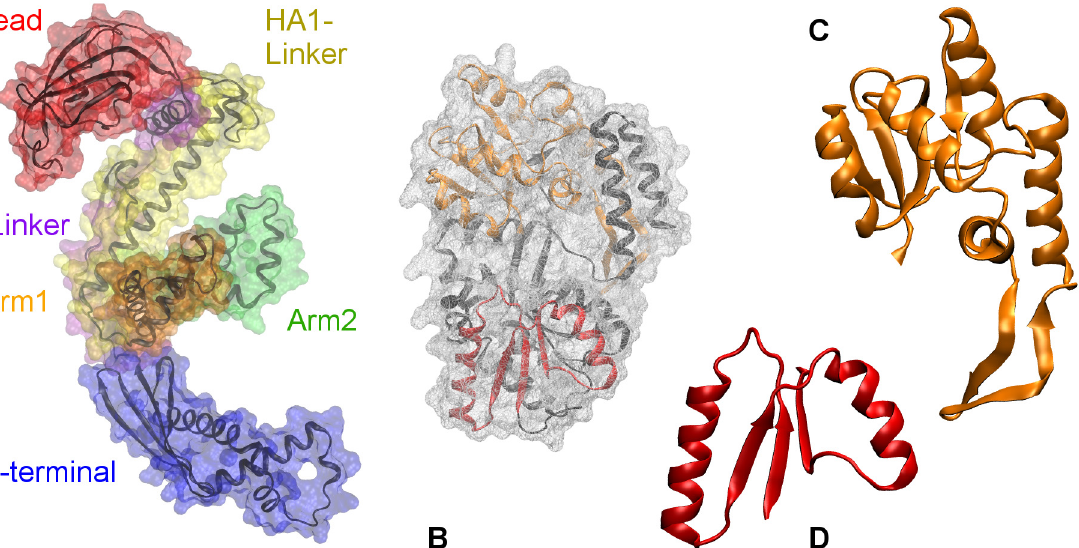
Fig 1. Crystal structures of. A. Trigger factor (TF, PDB code: 1W26). The surface of the protein is shown as transparent wire-mesh around the backbone. The surfaces of TF domains are colored differently: N-terminal in blue, Linker in indigo, PPIase domain in red, HA1-linker in yellow, Arm1 in orange, and Arm2 in green; B. Maltose binding protein (MBP, PDB code: 1JW4). The surface of MBP is colored gray, while the structure is colored black. Truncate of MBP ’ s folding intermediates: C. P2 with a backbone in orange and D. P1 with a backbone in